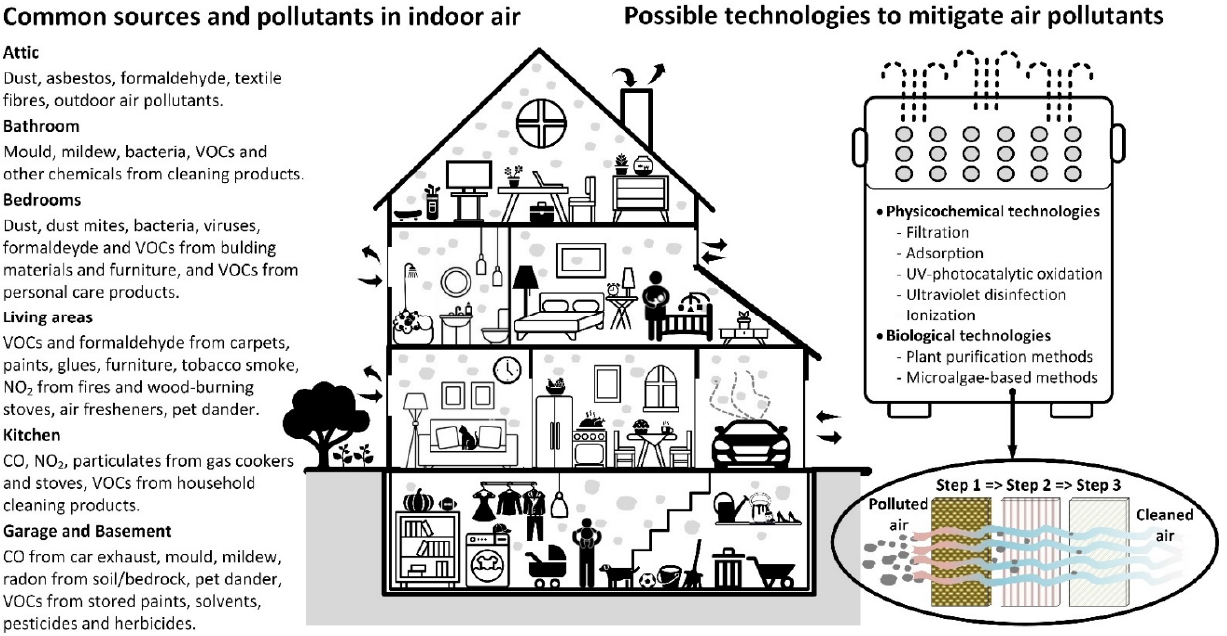
Figure 1. Common sources and pollutants in indoor air and some possible technologies to mitigate them (authors’ own creation).